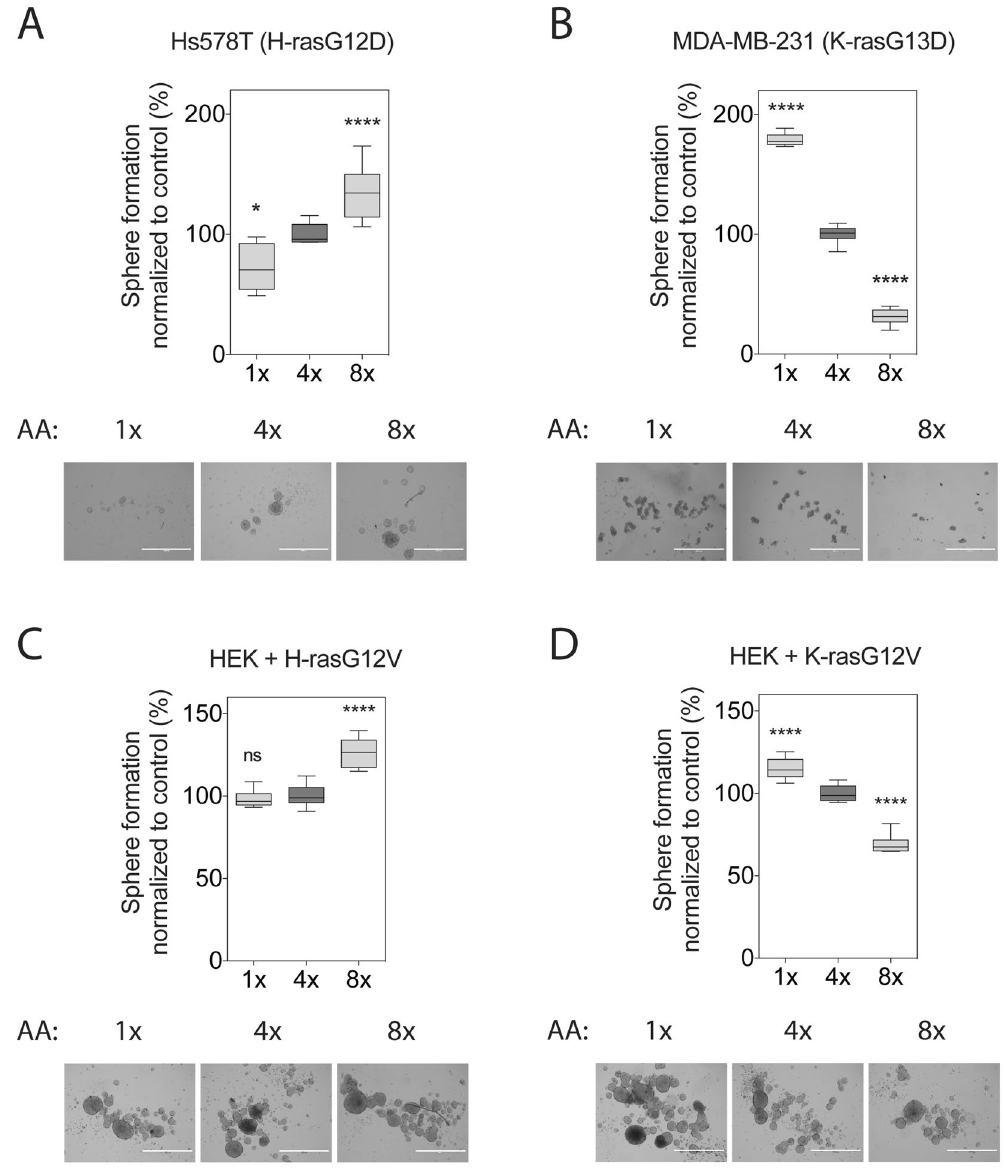
Figure 3. Tumourosphere growth follows Ras nanoclustering and MAPK-signalling. Sphere-forming efficiency of the breast cancer cell lines ( A ) Hs578T or ( B ) MDA-MB-231, and of the oncogenic ( C ) H-ras- or ( D ) K-ras- expressing HEK cells, grown under increasing amino acid concentrations for 9 days (n = 3). Representative images of spheres are shown below the plots. Scale bar in the images represents 1000 μ m. Statistical significance levels are annotated as ns, not significant; * p < 0.05; **** p <